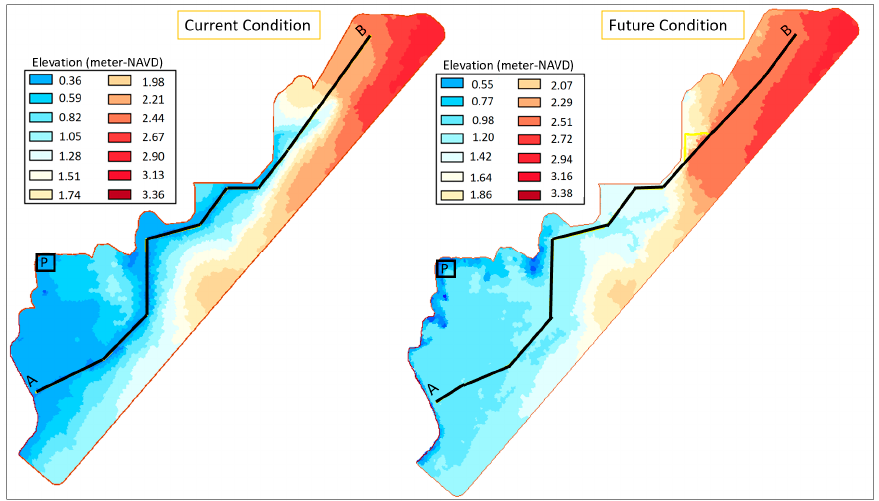
Figure 7. Spatial distribution of median groundwater elevations for current (2012) and future (2060) conditions. P denotes project site. B and A show the start and end of the main drainage flow path (black line), respectively.